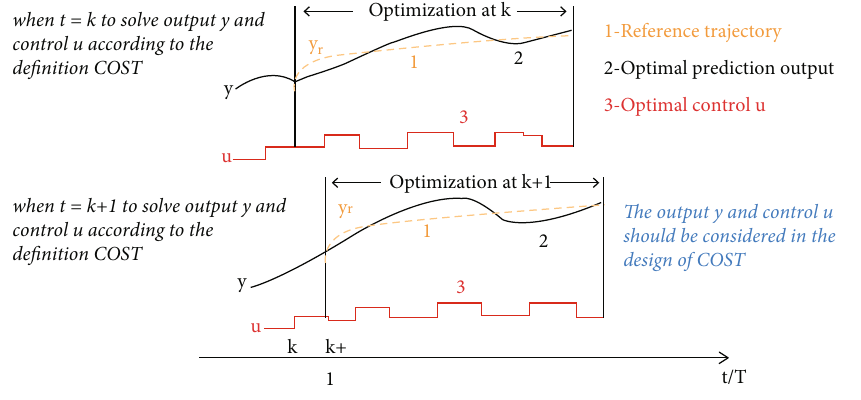
Figure 4: Receding horizon